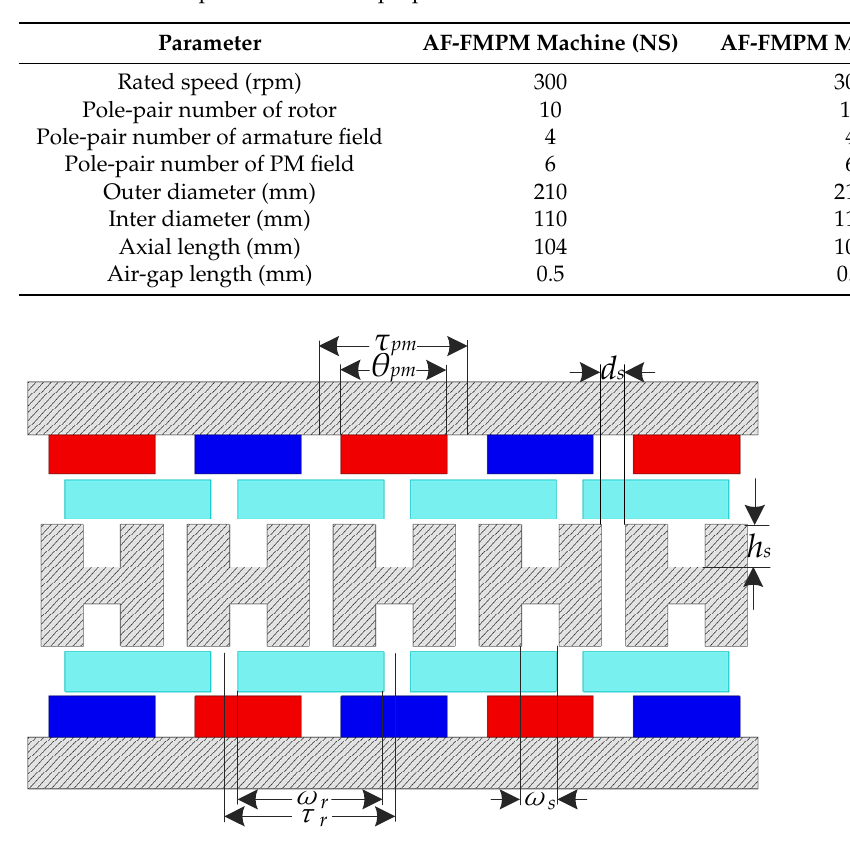
Table 1. Constant parameters of the proposed machine.